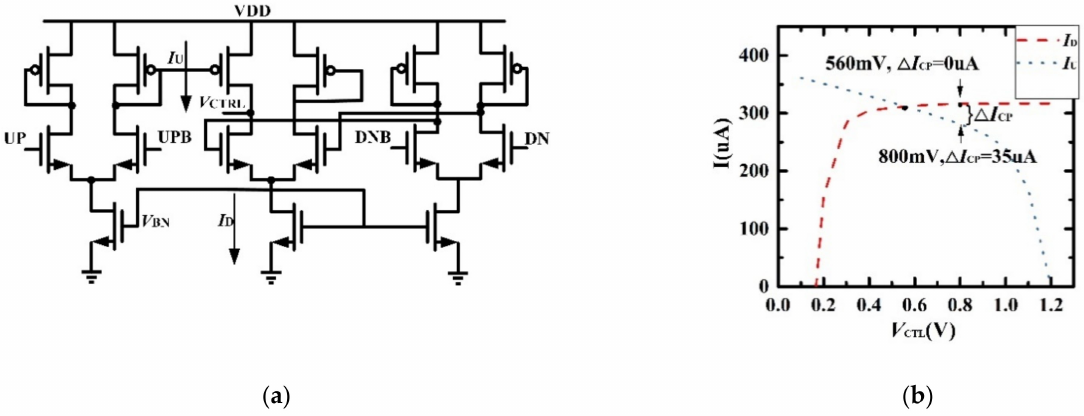
Figure 2. Charge pump ( a ) circuit diagram; ( b ) mismatch current at different output